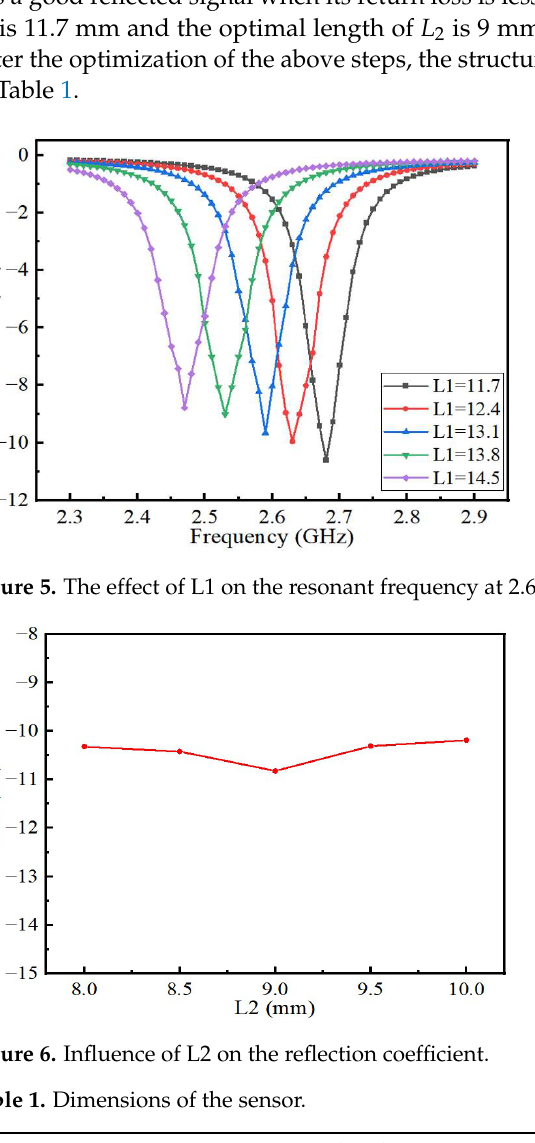
Table 1. Dimensions of the sensor.